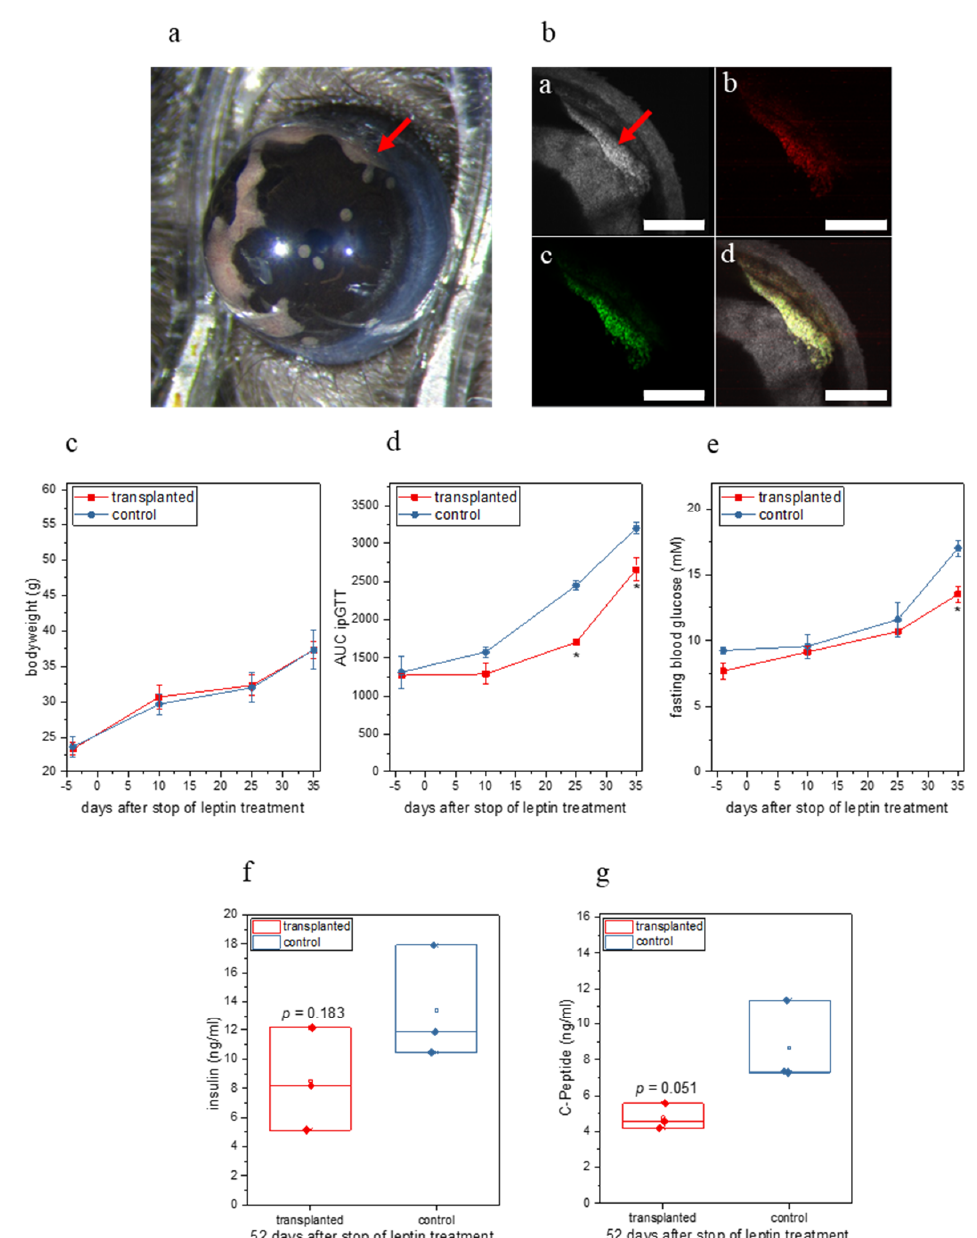
Figure 2. In vivo characterization of leptin-expressing islet organoids from the first set of experiments. ( a ) Photograph of the eye containing the leptin-expressing islet organoid graft (red arrow) 9 weeks after transplantation. ( b ) Maximum projection of a 3D-stack of a leptin-expressing islet organoid graft (red arrow) obtained by confocal imaging 9 weeks after transplantation; ( ba ) reflection, ( bb ) mCherry fluorescence, ( bc ) ZsGreen fluorescence, ( bd ) overlay image; scale bar 500 µm. ( c ) Bodyweight of transplanted and control mice over the entire period of the experiment. ( d ) Area under the curve (AUC) for ipGTT of transplanted and control mice over the entire period of the experiment. ( e ) Fasting blood glucose of transplanted and control mice over the entire period of the experiment. ( f ) Plasma insulin levels of transplanted and control mice at the end of the experiment. ( g ) Plasma C-peptide levels of transplanted and control mice at the end of the experiment. ( d , e ) * p < 0.05. ( c – g ) n = 3.